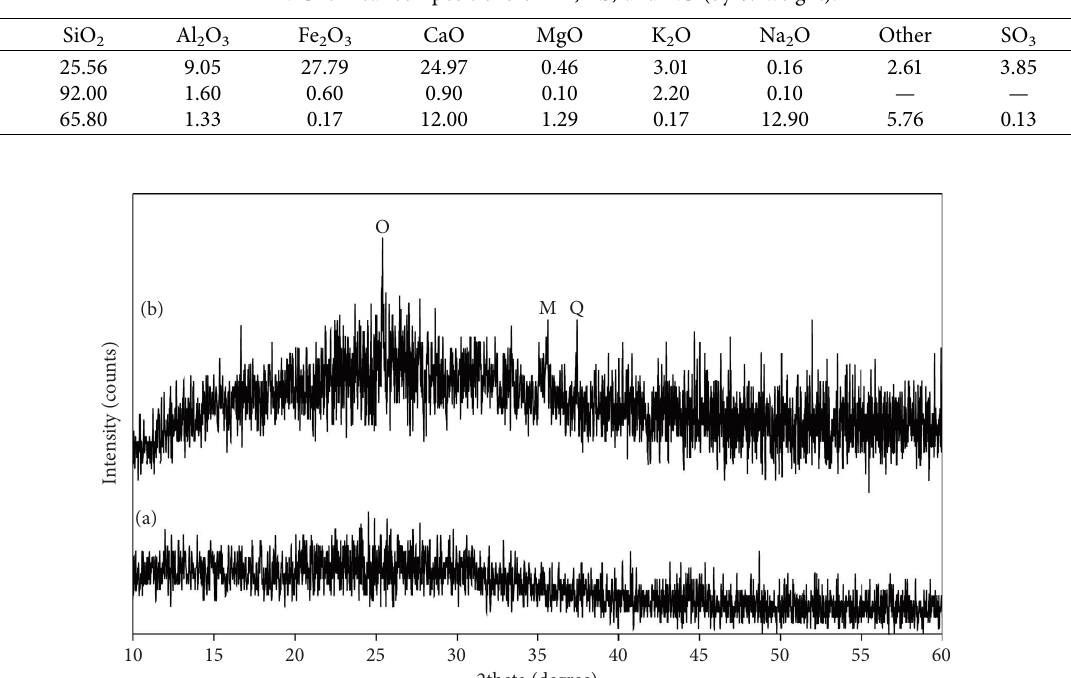
Figure 1: XRD patterns of materials: (a) RG and (b) FA (o � calcium sulfate (CaSO (SiO 2 )).